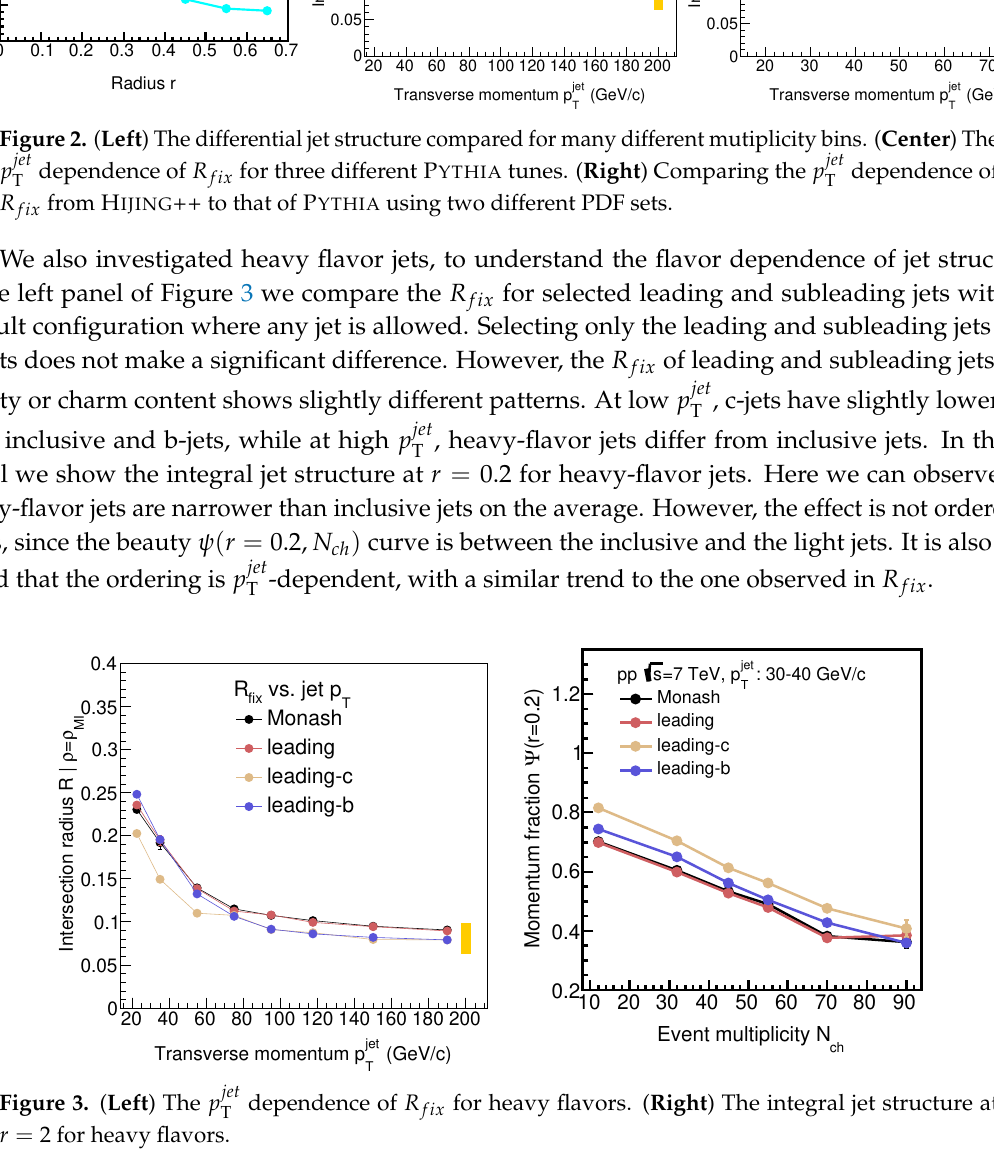
dependence of T